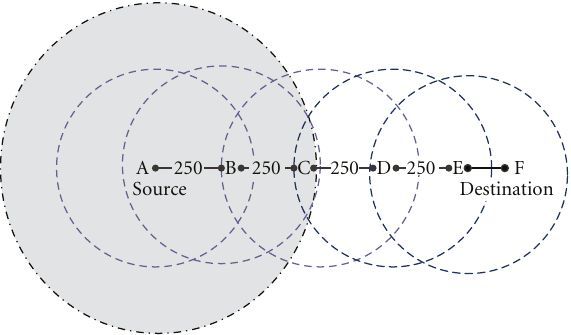
Figure 8: Example 1: A is the source and F is the destination. The carrier sensing range of node A is shown as shaded area. In this topology all nodes are equally spaced at 250 m